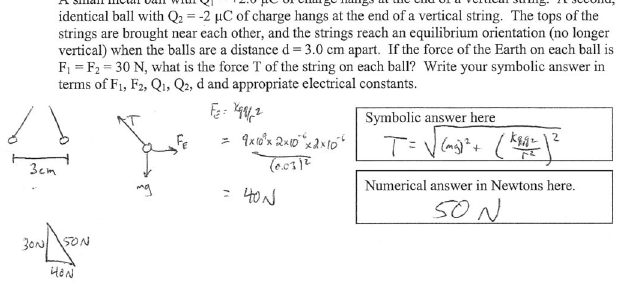
FIG. 2. Challenge problem with example solution. The picture drawn shows the common backwards picture error, as the balls are supposed to attract each other, leading to